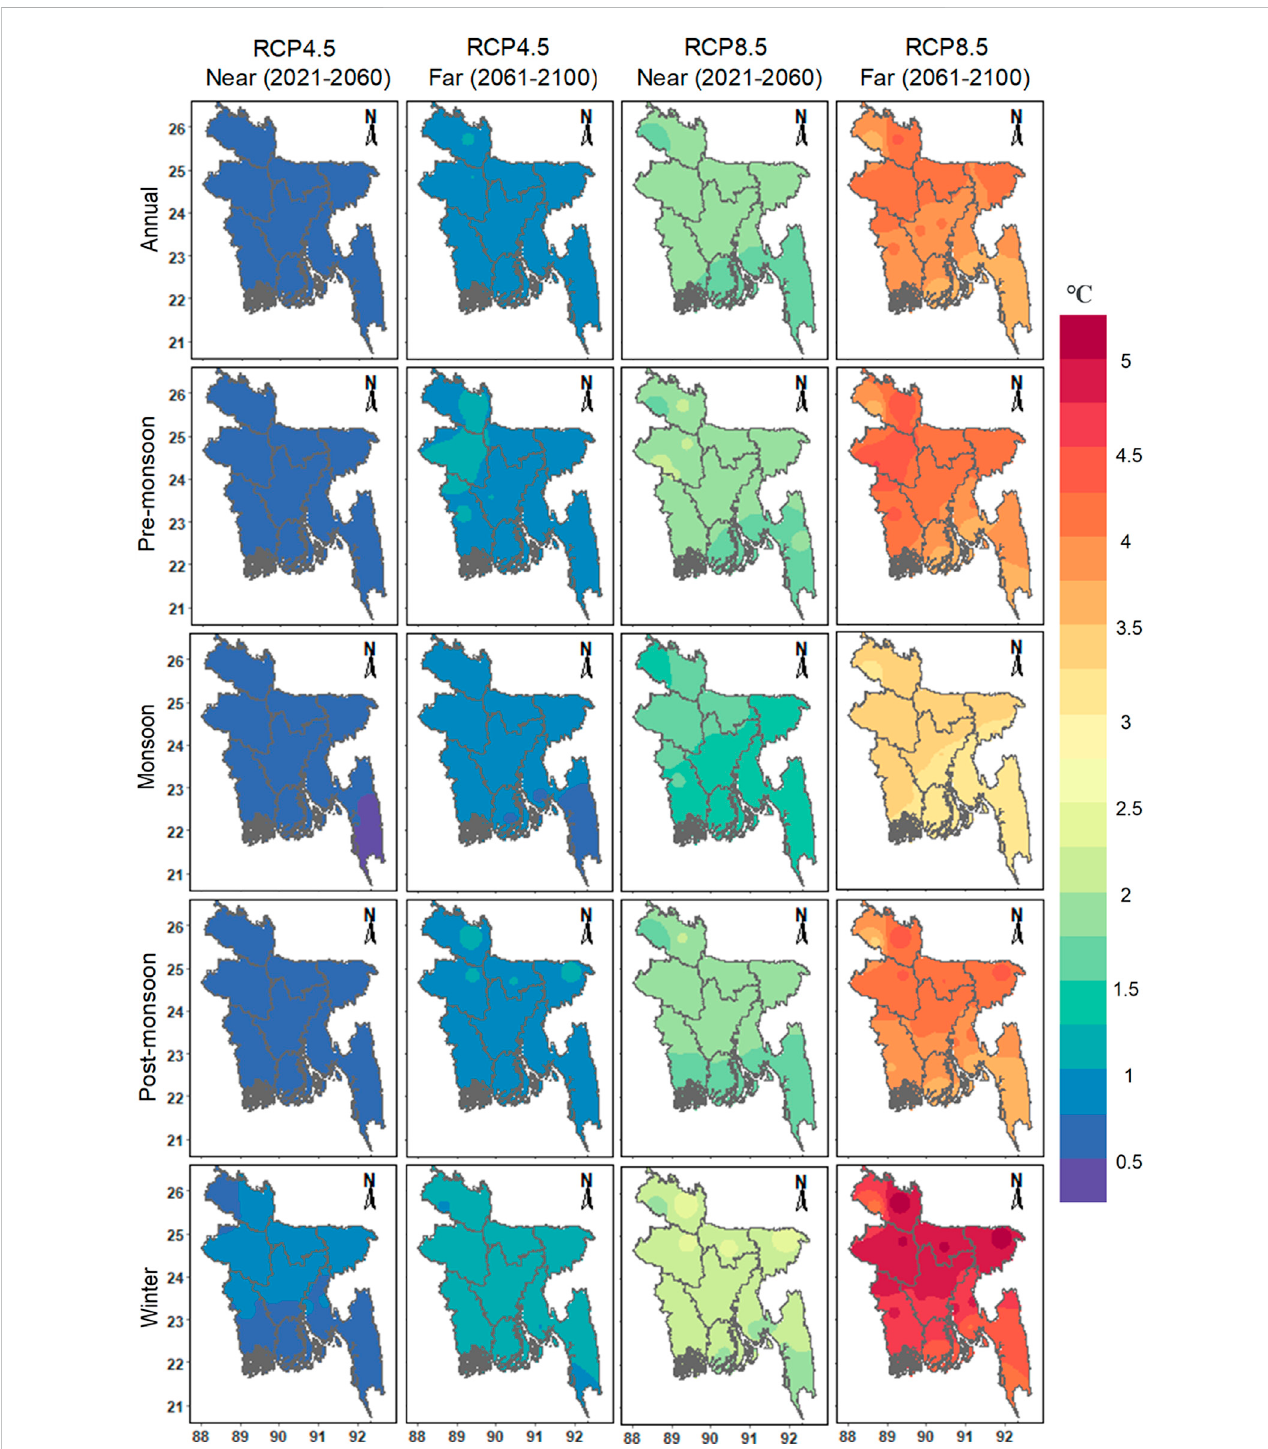
FIGURE 12 Spatial distribution of projected change in annual and seasonal Tmax ( ° C) for near (2021 – 2060) and far (2061 – 2100) future periods in Bangladesh for